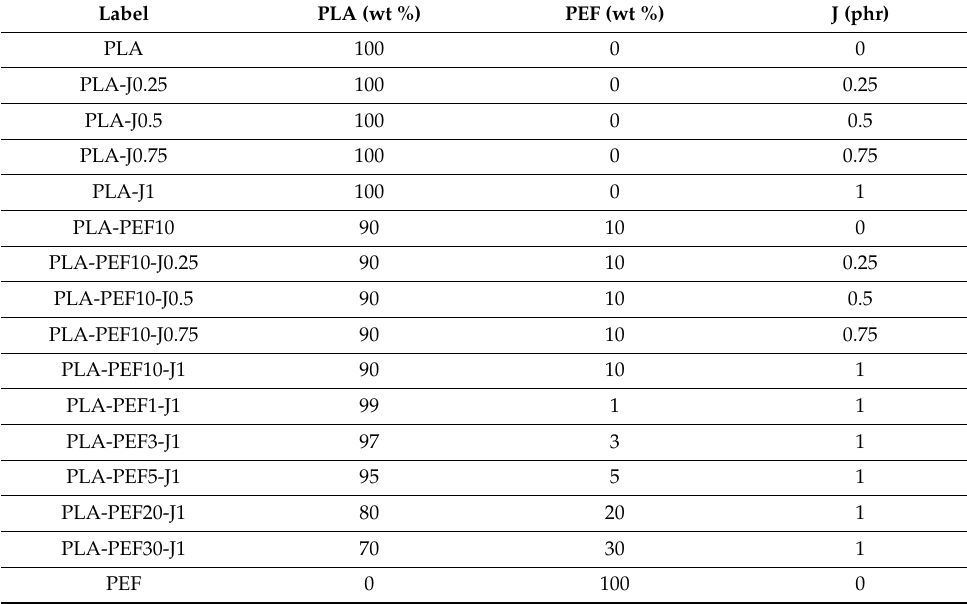
Table 5. List of the prepared samples with nominal weight